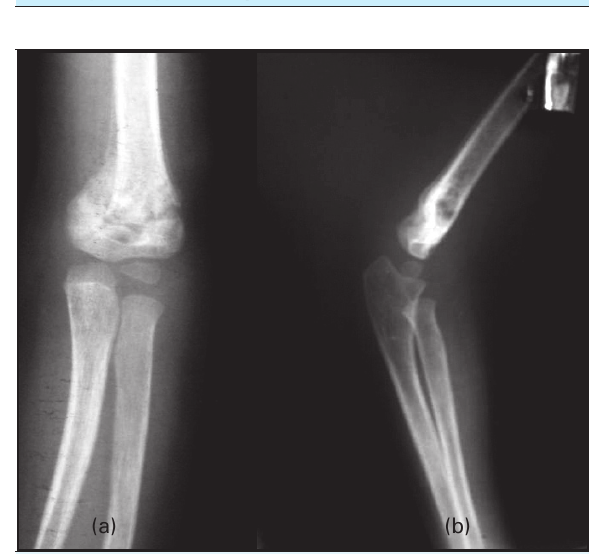
Figure 3. After K-wire fixation and POP back slab (a) anterior-posterior (AP) and (b) lateral view on fourth week post-operatively